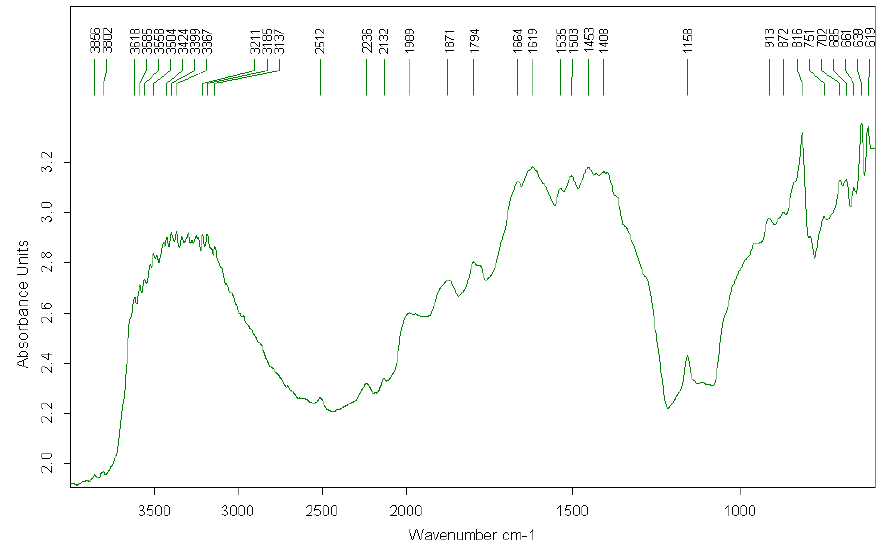
uie tea- Pe Cet ă t , ,